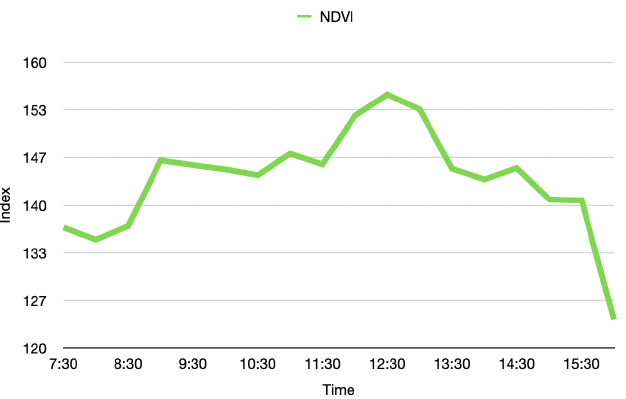
Figure 19. Average vegetative index NDVI of the Guaiacum plant during the day.